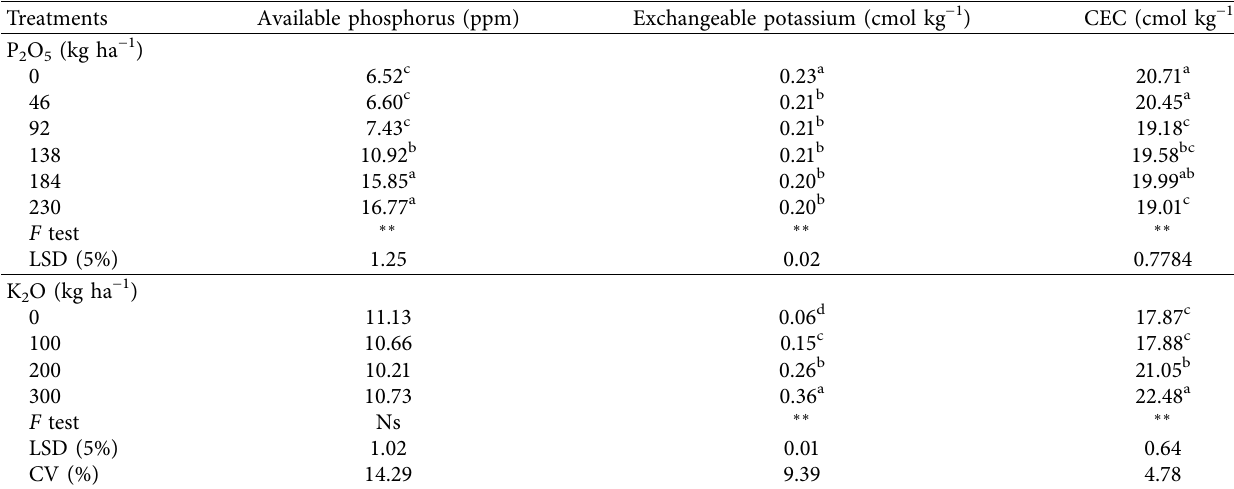
where ∗∗ � indicate signifcant diference at 1%; Ns � nonsignifcant at 5% level of signifcance; d.f � degree of freedom; CEC � cation exchange capacity; P � phosphorus (P 2 O5); K � potassium (K 2 O). Table 3: Main efects of phosphorus and potassium fertilizers on available phosphorus, exchangeable potassium, and CEC status of the soil after harvest.